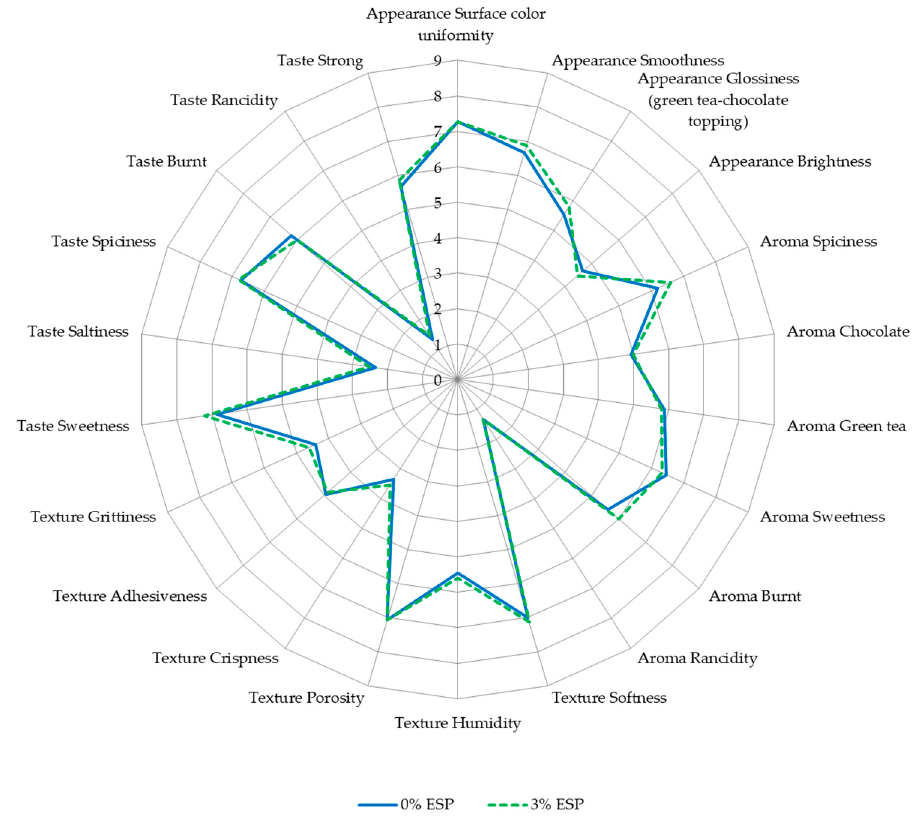
Figure 4. Sensory profiling of fresh gingerbread samples; ESP: egg shell powder.